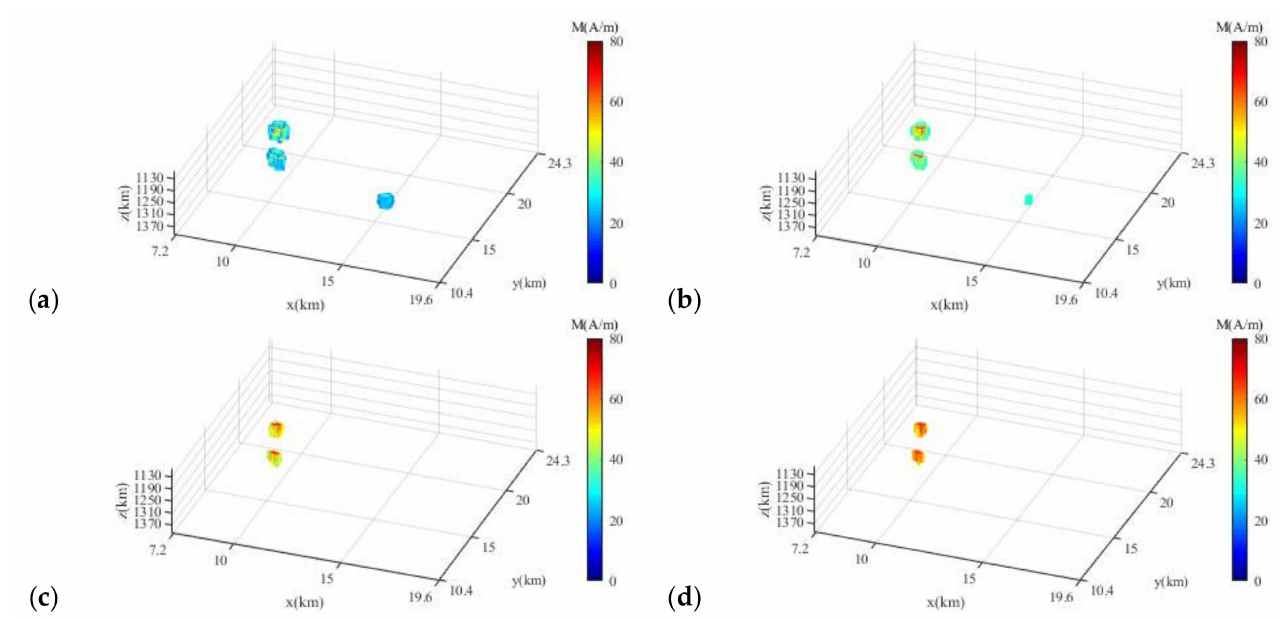
Figure 12. Inversion results of magnetite-caused anomalies in Litun Pluton subregion: ( a ) magnetization less than 20 A/m removed; ( b ) magnetization less than 30 A/m removed; ( c ) magnetization less than 40 A/m removed; ( d ) magnetization less than 50 A/m